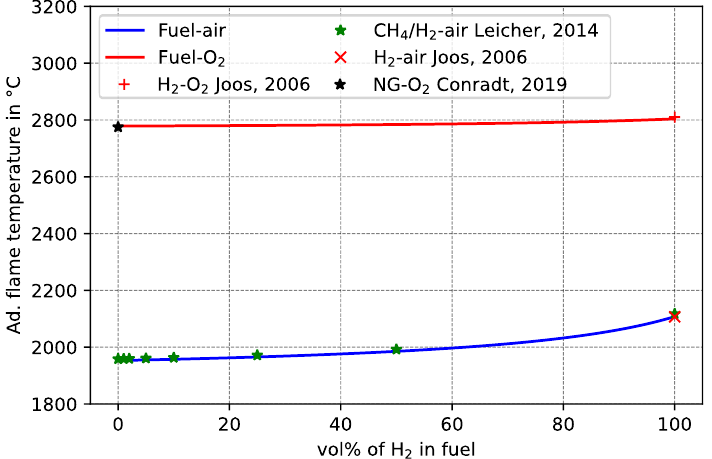
Figure 8. Comparison of the predicted adiabatic flame temperatures with increasing H 2 vol% in the fuel mixture with literature values for CH 4 /H 2 -air combustion (Leicher, 2014 [61]), pure H 2 -air combustion (Joos, 2006 [54]) and natural gas (NG)-air combustion (Conradt, 2019